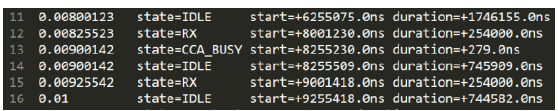
Figure 2. Acquisition of the Transmitter States.